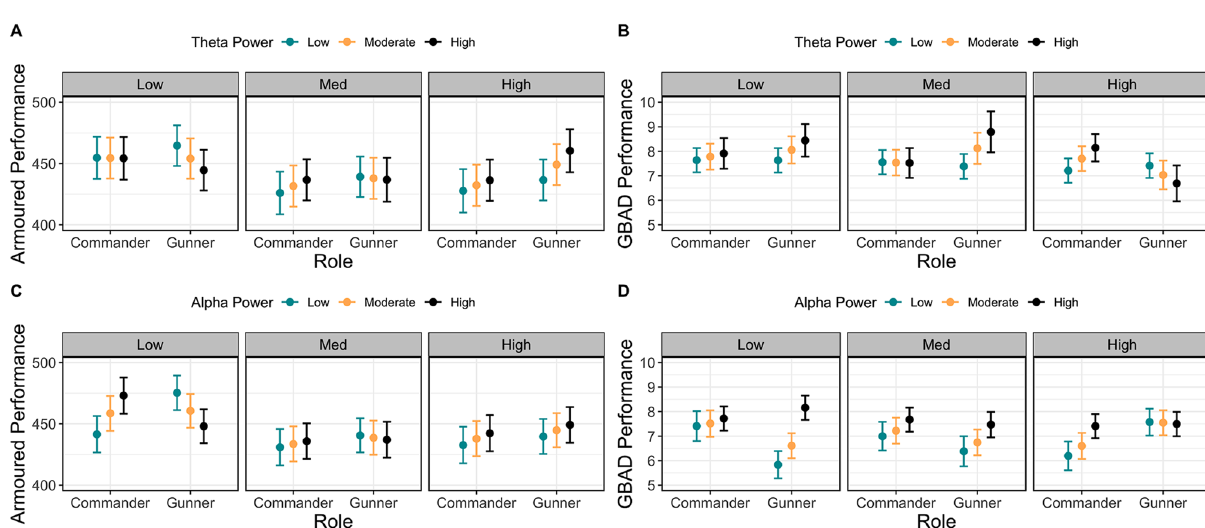
Figure 3. Modelled effects of task-related theta and alpha activity on behavioural performance. ( A ) Relationship between performance ratings (y-axis; higher values indicate better performance), role (commander, gunner; x-axis), session (easy = left; medium = middle; high = right), and task-related theta power (blue = low power; yellow = moderate power; black = high power). Bars represent the 83% confidence interval. ( C ) represents the same as ( A ) but for task-related alpha power, while ( B , D ) represent the same but for performance on the tank simulator at Armoured. Here, performance is represented on the y-axis, with higher values indicating better performance. Note that power values (theta and alpha power) were discretised into low, moderate, and high values based on the first quartile, median and third quartile values for the purposes of plotting but were entered into the model as continuous